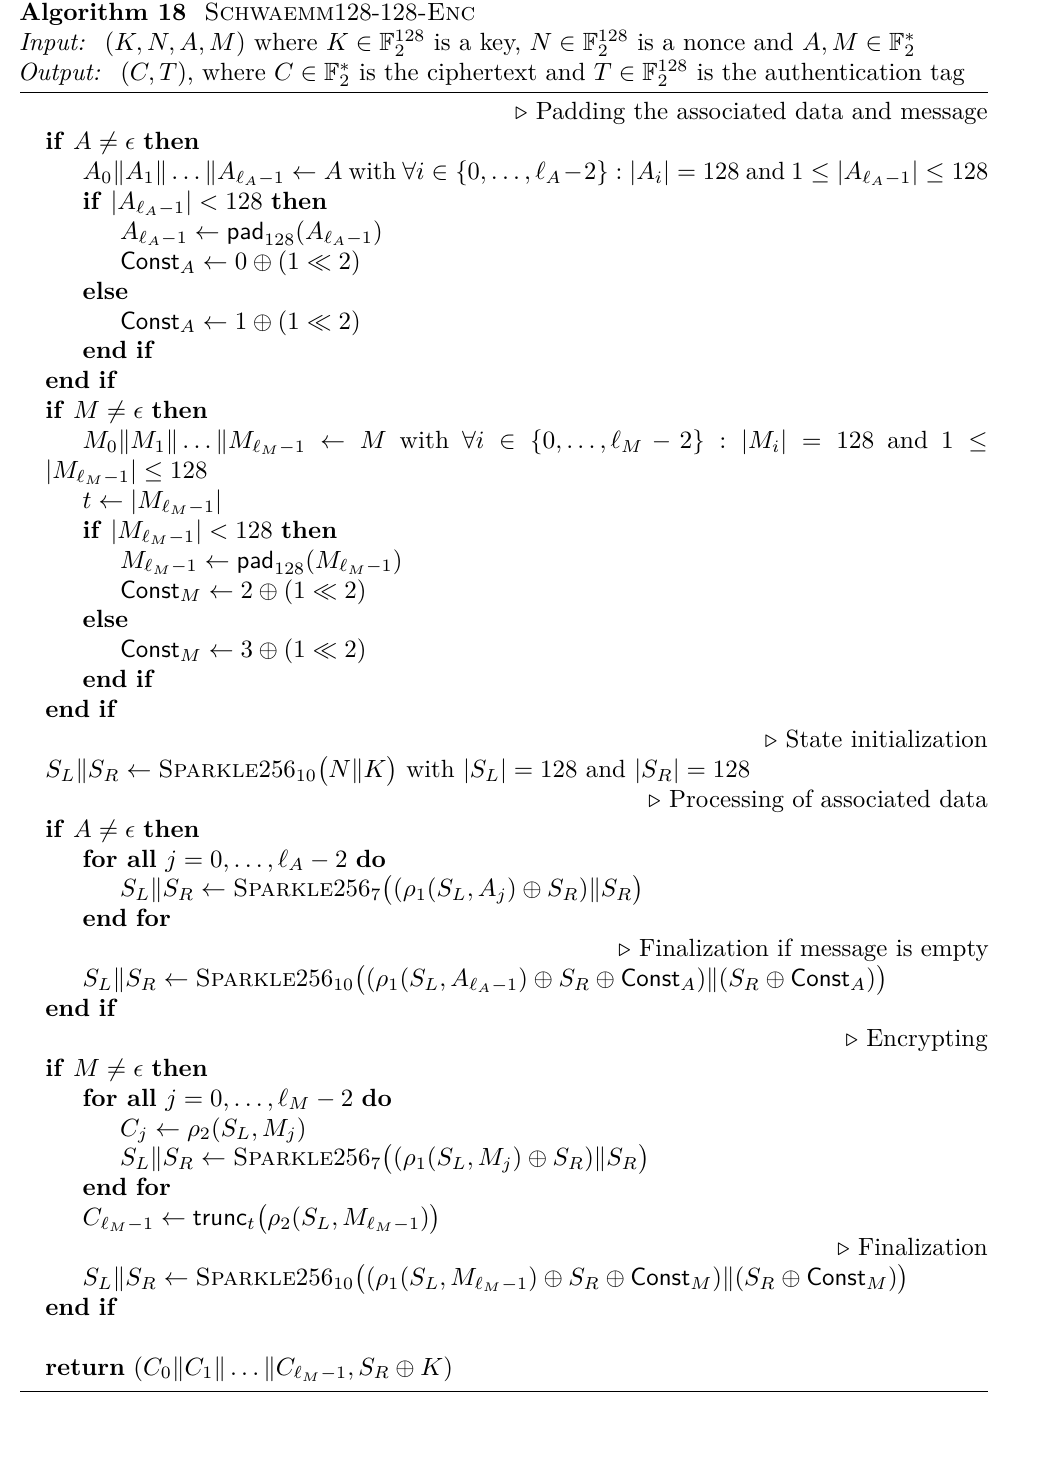
Algorithm 18 Schwaemm 128-128